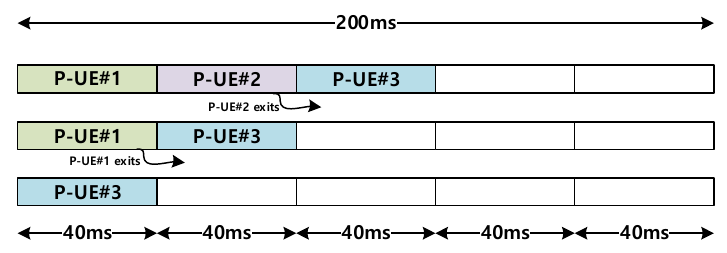
Figure 7. Realigning of partial sensing windows for P-UEs exiting the RSU coverage. Through the abovementioned procedure, each P-UE can acquire the sensing results for the time slot corresponding to its own window duration of 40 ms, and for the entire observation period of 200 ms. The only possible conflict included in the proposed procedure is that, as briefly mentioned in Figure 6, each P-UE selects its resources based on the sensing results obtained approximately 400 ms before the actual transmission. The key part of the proposed technique is that the total throughput of each P-UE is expected to increase almost to that of full sensing, which is five-fold larger than that of the conventional partial sensing